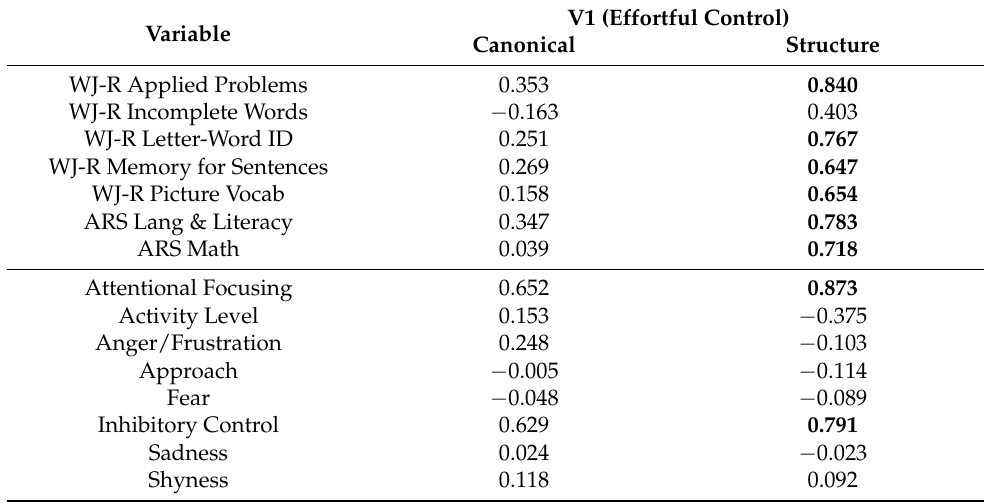
Table 1. Canonical solution for temperament predicting school readiness for variate 1.